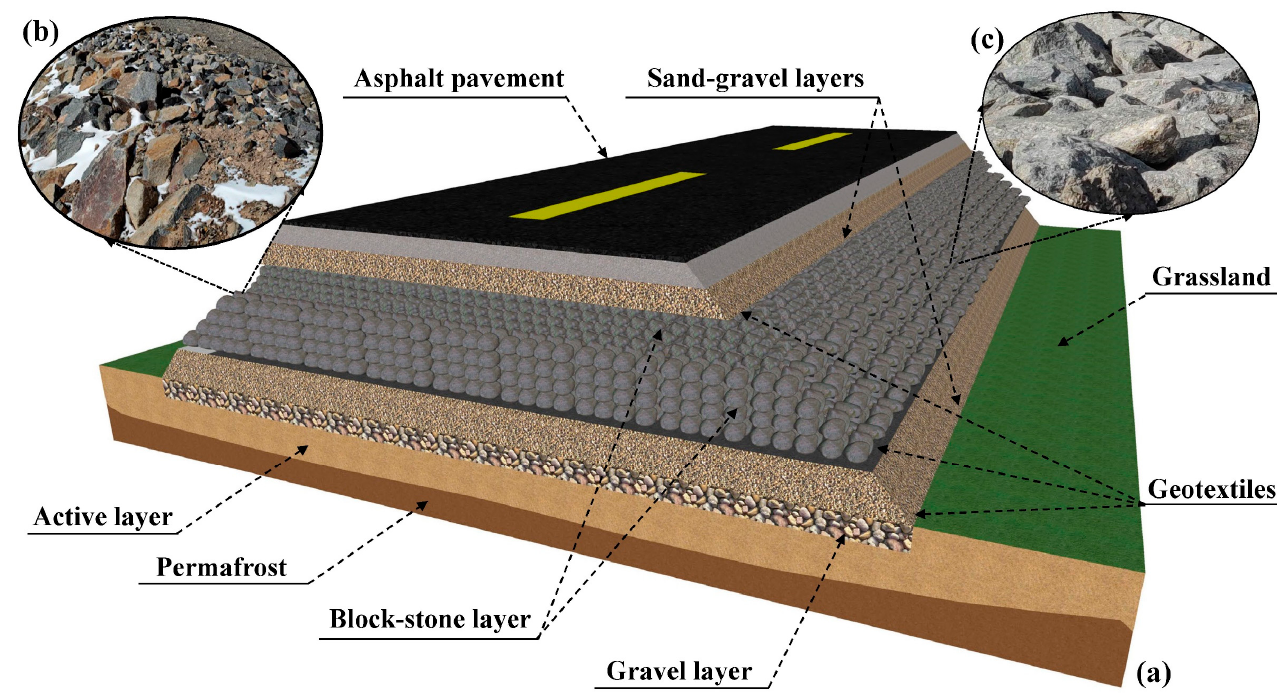
Figure 3. Schematic diagram of the block-stone embankment: ( a ) block-stone embankment structure; ( b , c ) field photographs of block-stone layer.